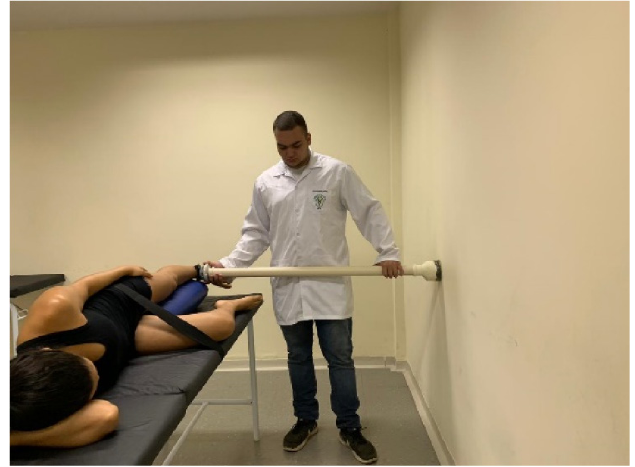
Figure 1 - Hip flexors (kgf/kg). Figure 2 - Hip extensors